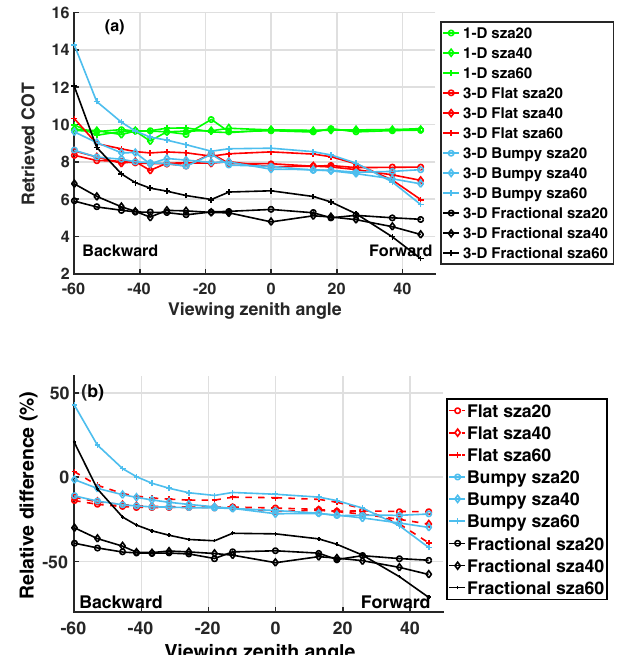
Figure 4. (a) Cloud optical thickness (COT) retrieved with the POLDER operational algorithm as function of the viewing zenith angle for the four different simulated cloud cases (1-D, flat, bumpy and fractional clouds) and for different solar zenith angles (20, 40 and 60 ◦ ). (b) Relative differences [(COT3-D − COT1-D) / COT1- D × 100] between the heterogeneous cloud (3-D) and the homoge- nous cloud (1-D)